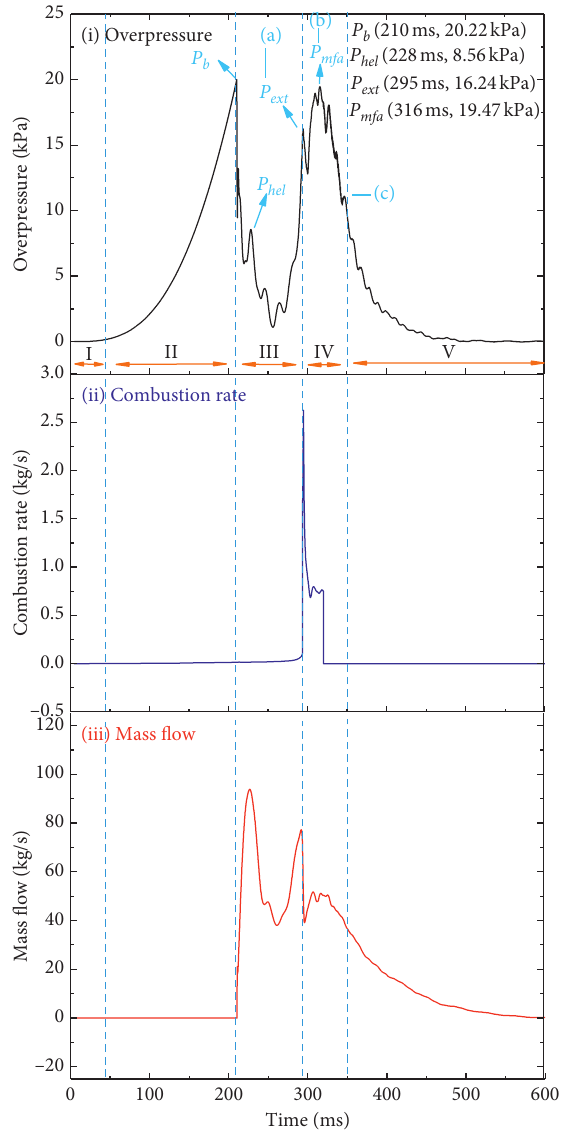
Figure 7: Time history curve of (i) overpressure, (ii) combustion rate, and (iii) mass flow near the vent (gauge 12).